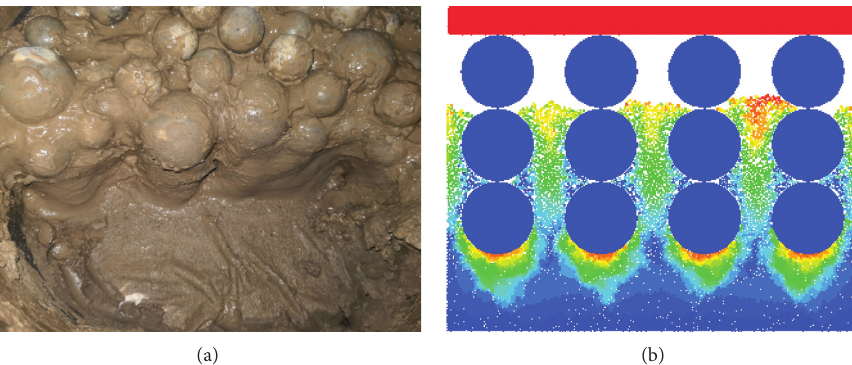
Figure 10: Comparison between numerical and test results: (a) test results with 100kPa external loading; (b) numerical results with 100 kPa external